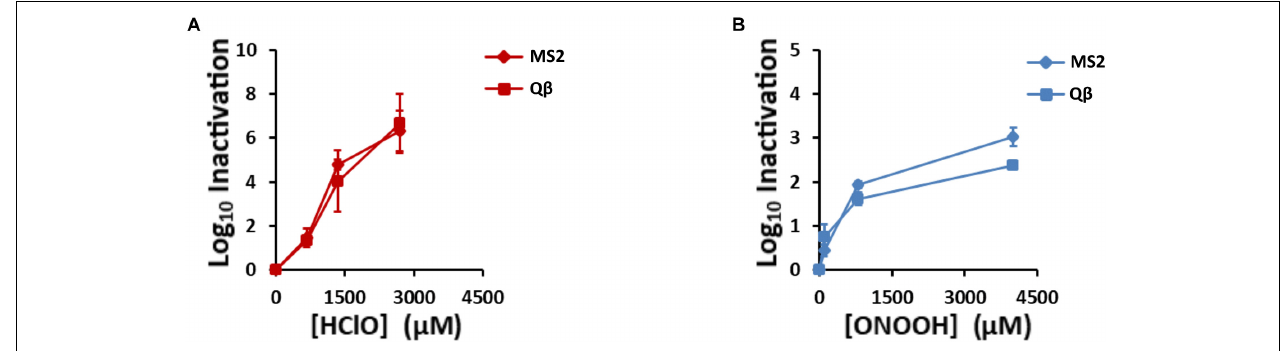
FIGURE 2 | HClO and ONOOH inactivate Q β and MS2 phages. Q β and MS2 inactivation levels increase with (A) , HClO and (B) , ONOOH concentrations. HClO- and ONOOH-induced inactivation curves are plotted in function of the concentrations of the oxidant. Diamonds and squares markers stand for MS2 and Q β phages, respectively. Each point on the curves is the result of at least three independent experiments carried out on separate days. Error bars stand for SEM.